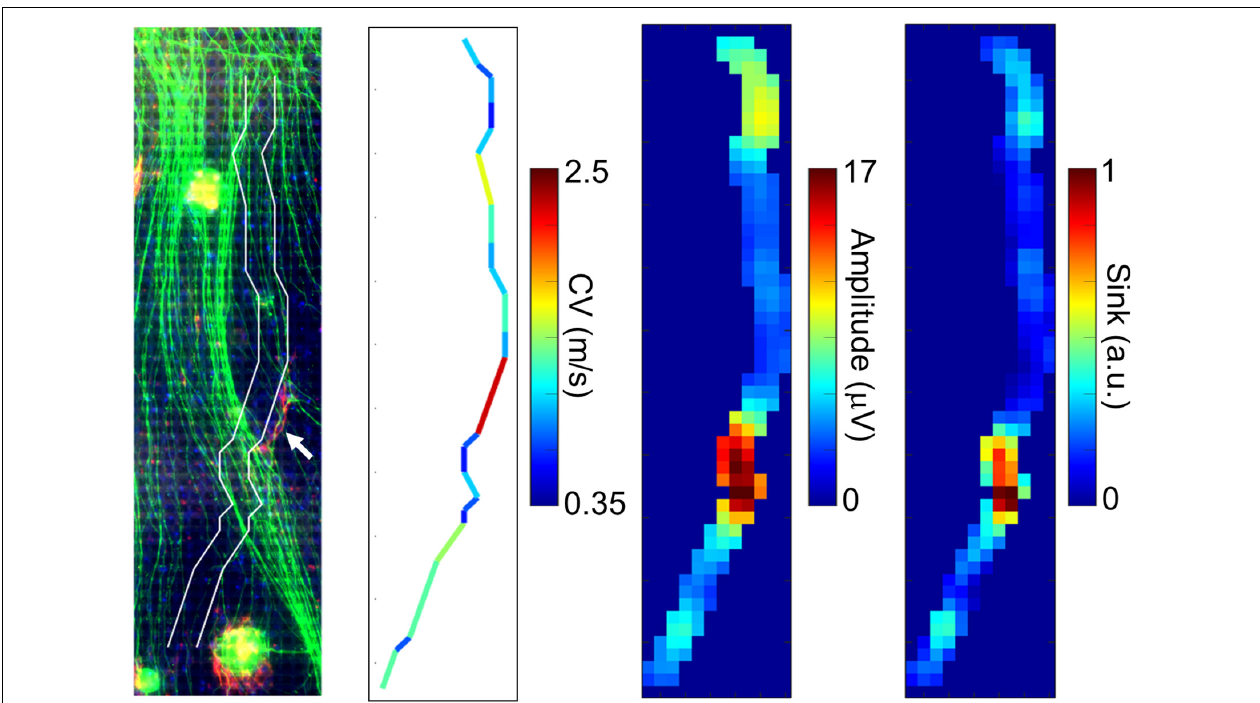
FIGURE 4 | Comparison between immunofluorescent image and fast conducting segment. The detected axon segment is stacked on the immunofluorescent image using antibodies to beta III tubulin (green) and P0 protein (red). The axon segment is positioned between two white lines. The white arrow shows the position of P0-positive segment. The fast-conducting segment, low amplitude, and sink position were located in vicinity of the P0-positive segment. More than 20 spikes were averaged at each electrode. Electrical recording at 61 DIV, immunofluorescent imaging at 77 DIV.